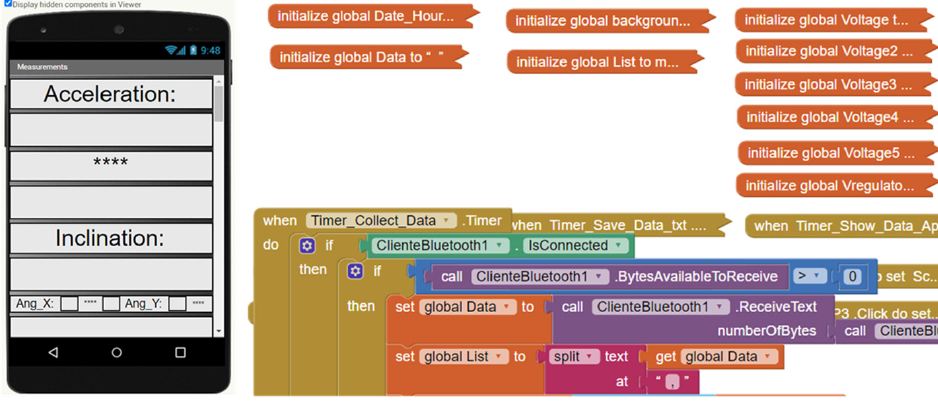
Figure 4. The App Inventor application, showing the graphic display and block programming.